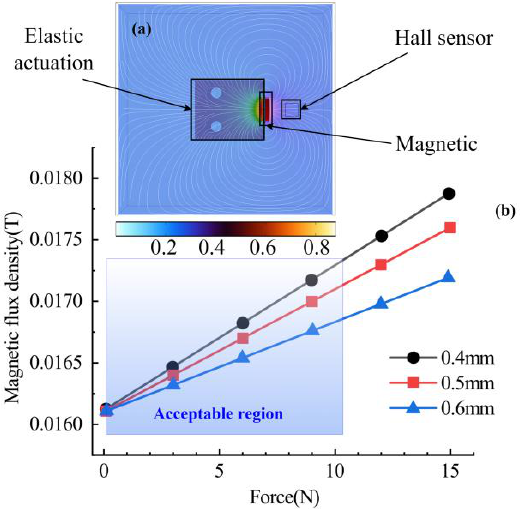
Figure 8. Results of simulations of the variation in magnetic field strength of different elastic actuators: ( a ) simplified cross-sectional view of the gripper, showing the deformation of the elastic actuator and the distribution of magnetic lines of force; ( b ) the variation in magnetic flux density due to different forces.